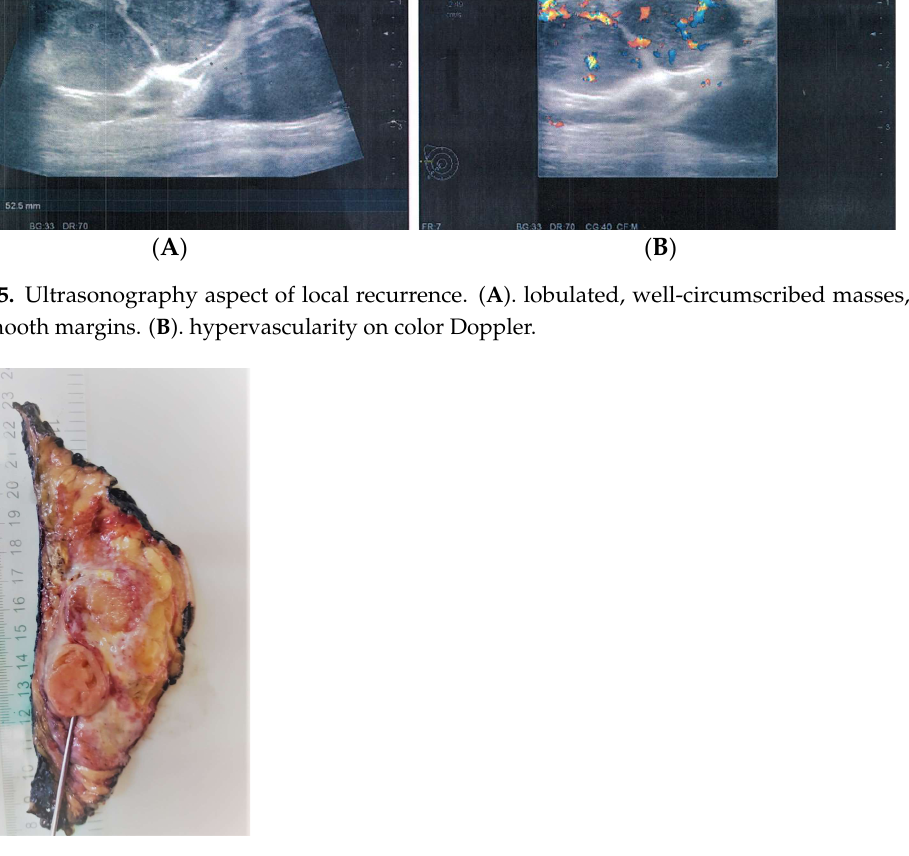
Figure 6. Mastectomy specimen with macroscopic aspect of the local recurrences.